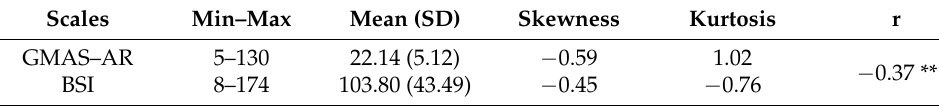
Table 2. Total and Subscales Scores of GMAS–AR and